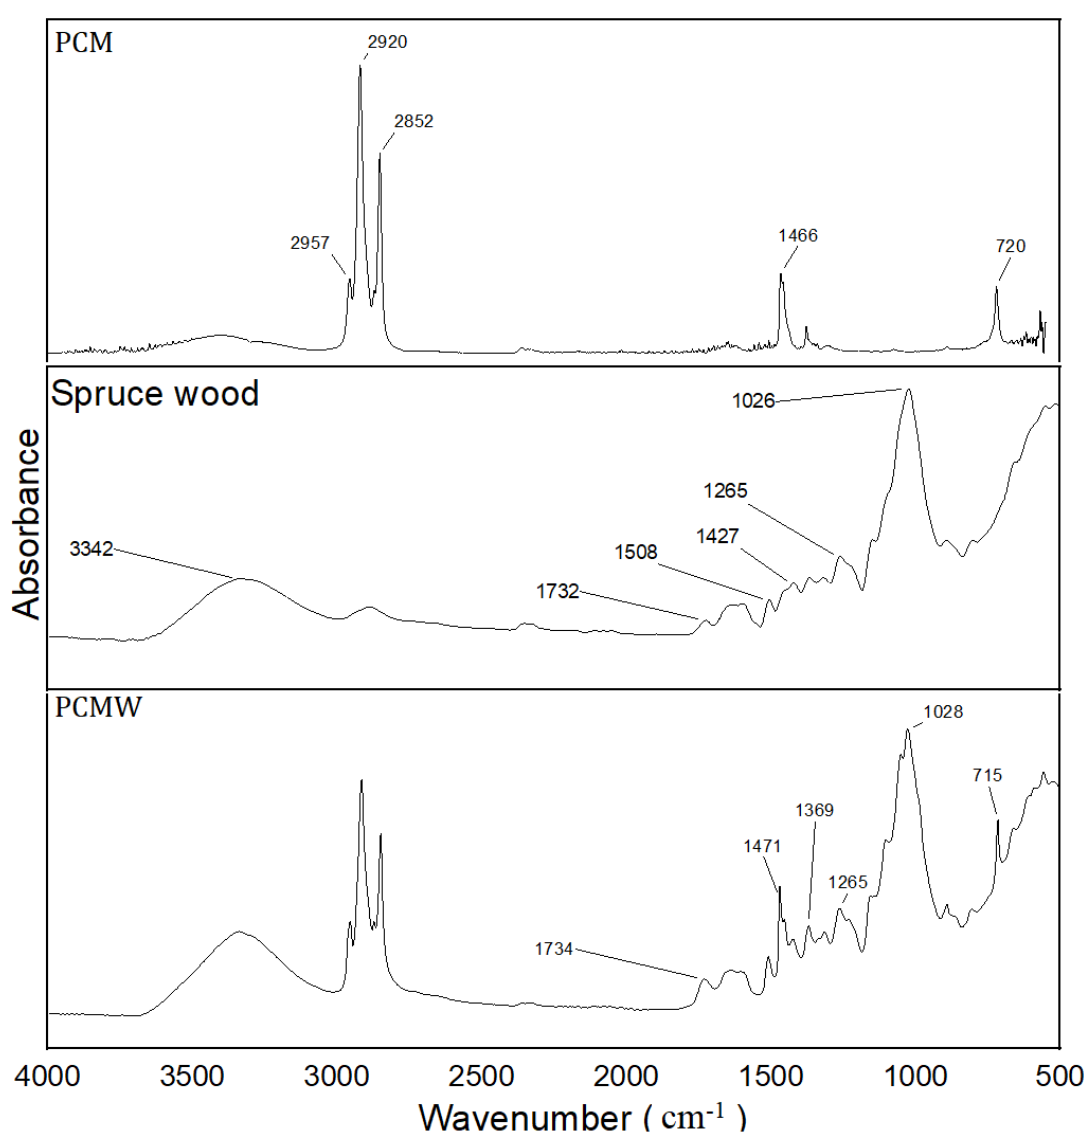
Figure 1. FTIR-ATR spectra of the PCM (nHD) and PCMW.